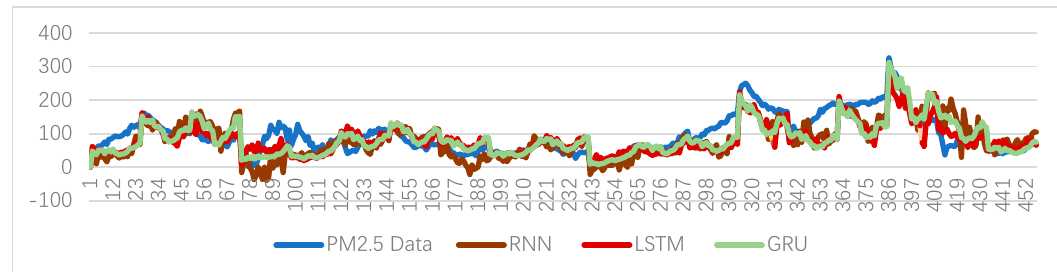
Figure 7. The predictions of hourly PM2.5 in Beijing from 1 to 20 December, 2017 by RNN [31], LSTM [32], GRU [34].